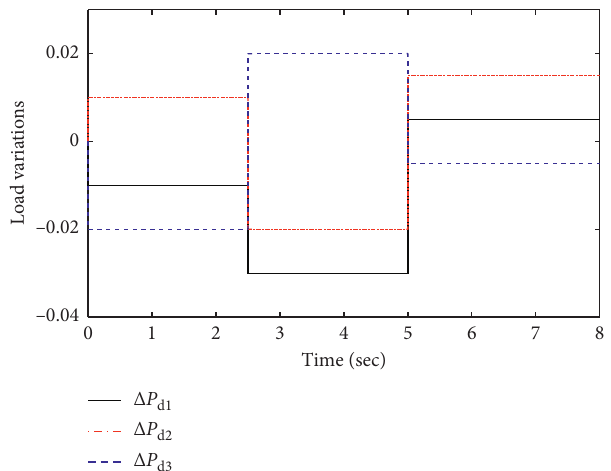
Figure 11: Load variations of three-area power network.